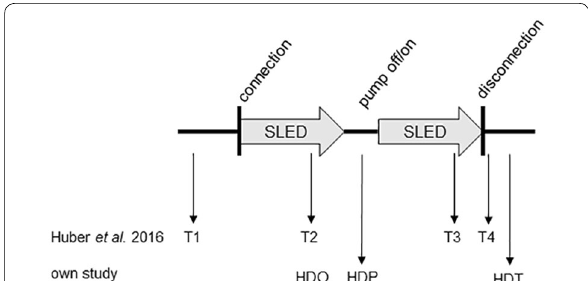
Fig. 3 Comparison of the measurement time points to investigate the influence of ongoing SLED on TPTD results between Huber et al. 2016 and our study. Huber et al. 2016 performed their TPTD measurements before connection of the pump (T1), during SLED with pump on (T2), during SLED with pump on after pausing the RRT (T3) and after disconnection (T4). We performed our measurements during SLED (HDO), at paused SLED (pump off/on, HDP) and after termination (HDT)